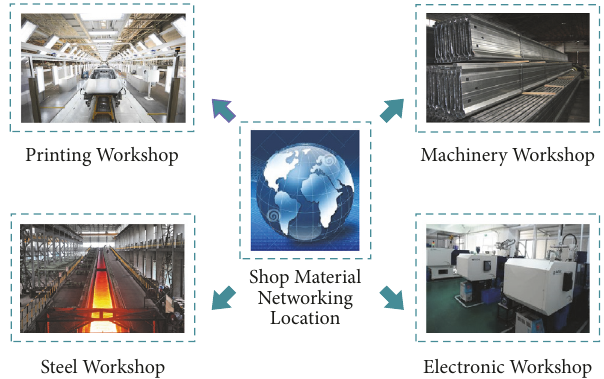
Figure 3: Positioning of Workshop Internet of